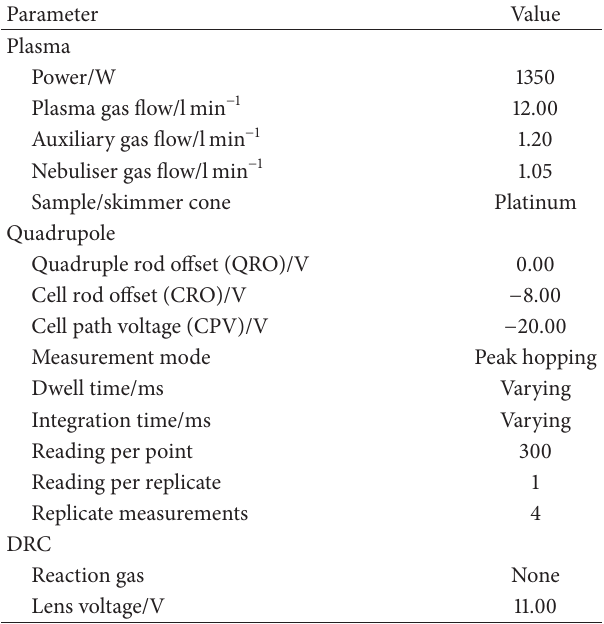
Table 1: Spectrometer’s running